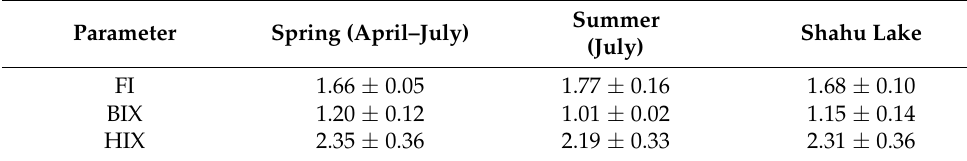
Table 3. Average FI, BIX, and HIX of Shahu Lake.